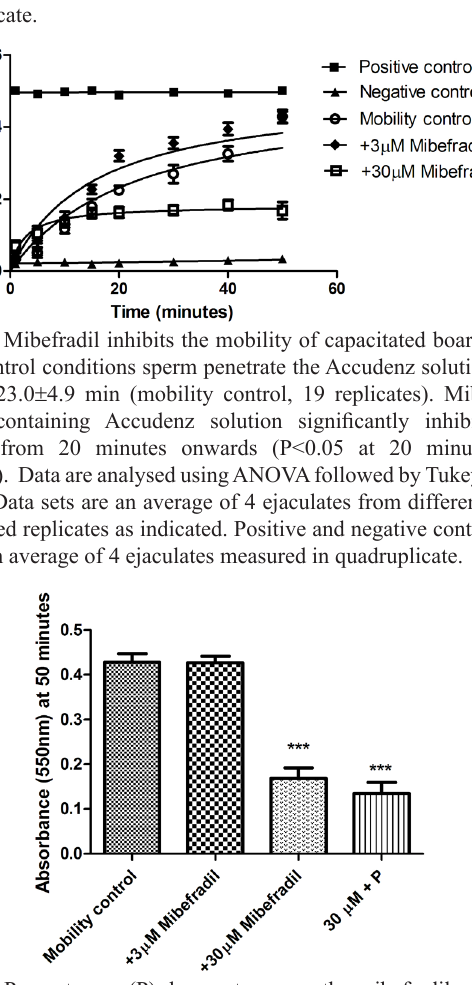
Figure 6. Progesterone (P) does not recover the mibefradil mediated inhibition of mobility of capacitated boar sperm cells. Maximum absorbance values at 50 minutes are given for sperm penetrating the Accudenz solution only (mobility control, 19 replicates) or containing mibefradil (M, +3/30 m M, 14 and 21 replicates respectively) or 30 m M mibefradil and 100nM Progesterone (+30 m M M + 100nM P, 20 replicates). Data are analysed using ANOVA followed by Tukeys post-hoc test. Asterisks (P<0.001) indicate significantly different from mobility control. Data sets are an average of 5 ejaculates from different boars with pooled replicates as indicated. Positive and negative control data sets are an average of 4 ejaculates measured in duplicate.